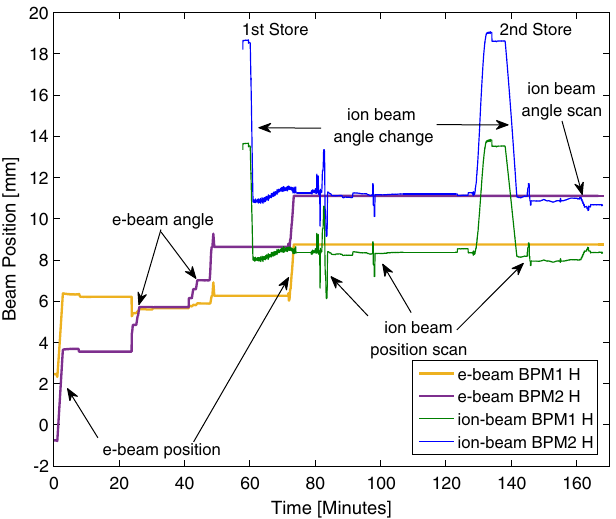
FIG. 21. Blue electron beam and ion beam alignment procedure for the horizontal